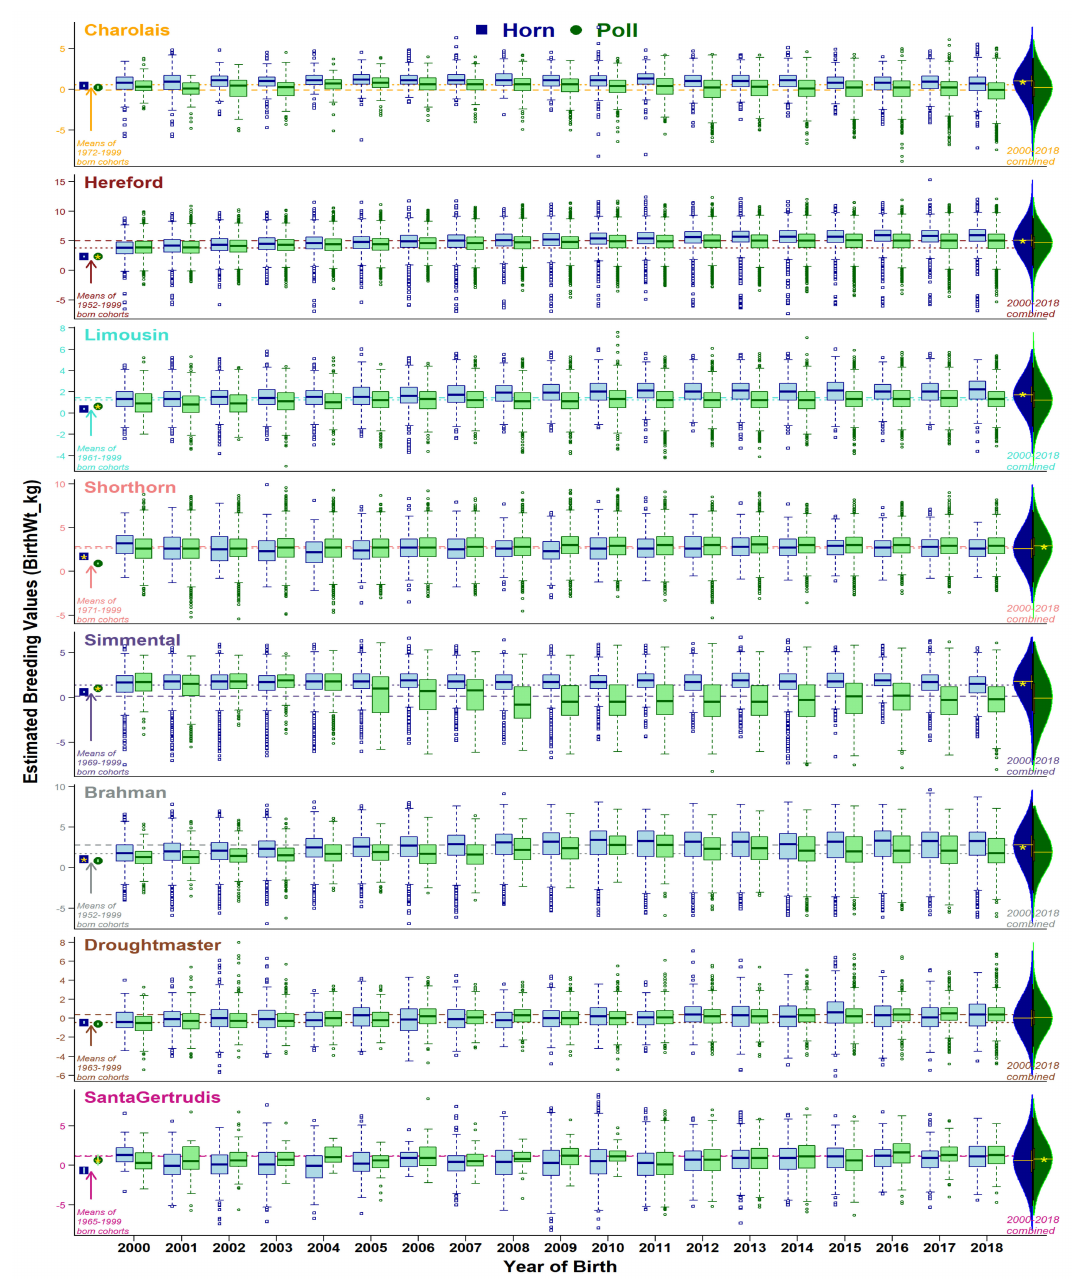
Figure 2. Boxplots of birth weight EBVs (accuracy ≥ 50%) for horn (blue) and poll (green) cohorts born from 2000 to 2018. Dotted and dashed lines show breed averages at the start (2000) and end (2018) of the selected period. Points at the left side of graphs show cohort averages for recorded animals born before 2000. Violin plots on the right side show the distribution of horn and poll cohorts during 2000 to 2018 combined, with a yellow star representing a statistical significance of mean